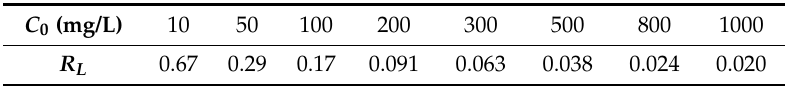
Table 2. R L for Pb(II) Removal by MIL-101-TEPA@CA Based on the Langmuir Model. C 0 (mg/L)